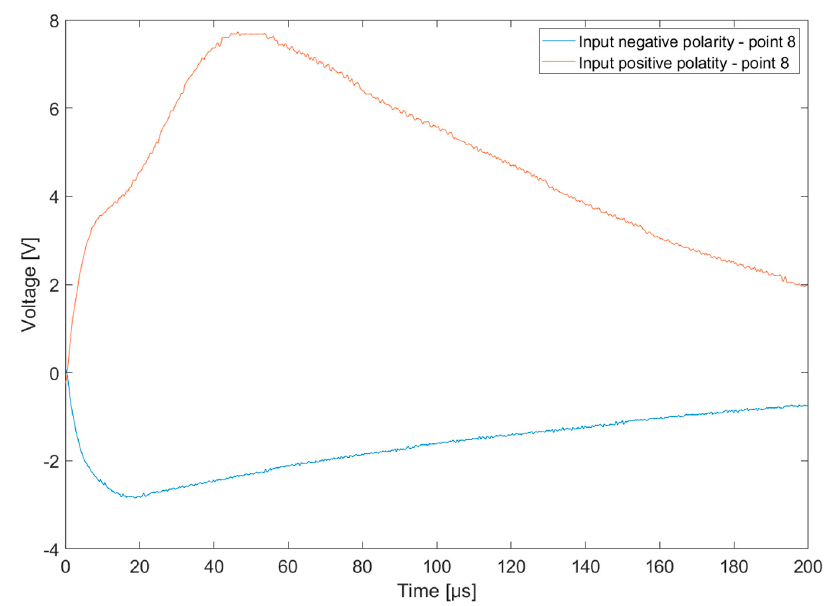
Figure 6. Value of surge pulse on supply bus (point no. 8) for both (negative and positive) polarity (negative polarity was inverted to show difference between them).